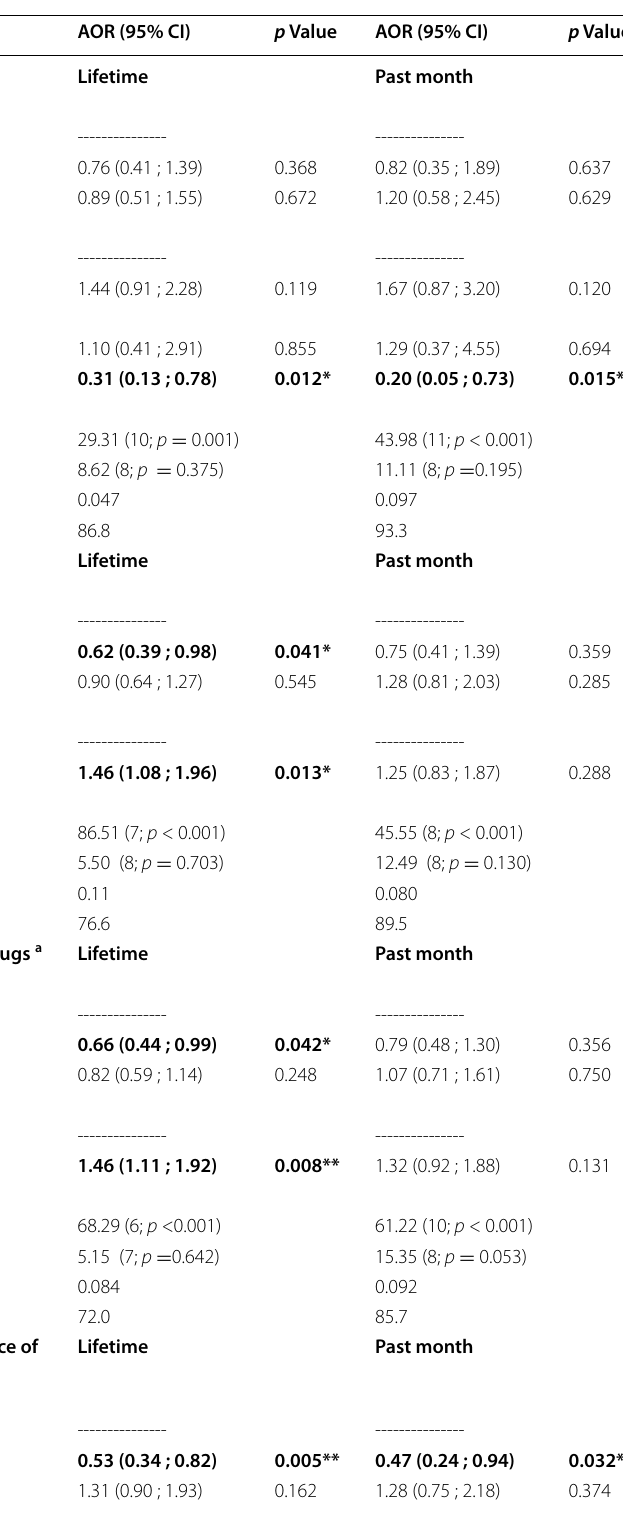
Table 5 Adjusted odds ratios (AOR) for driving under the